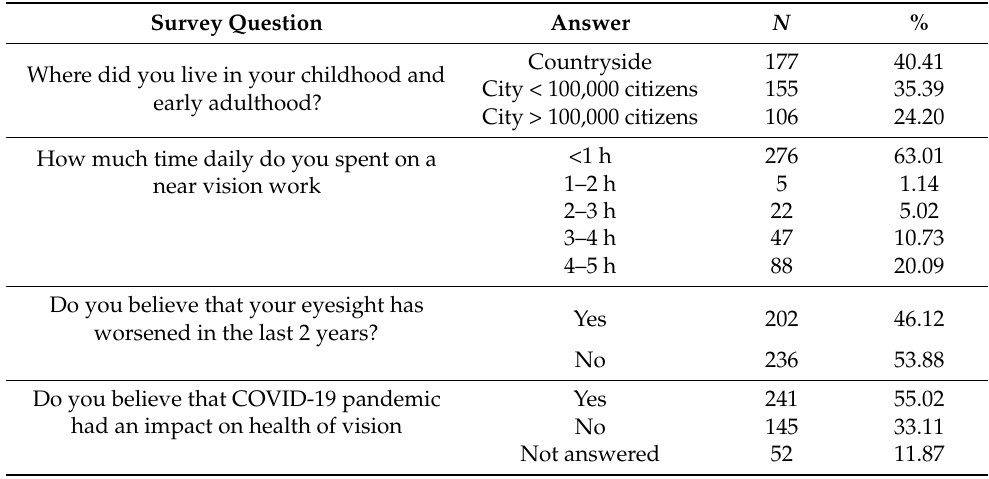
Table 1. Answers to survey questions are applicable to the whole